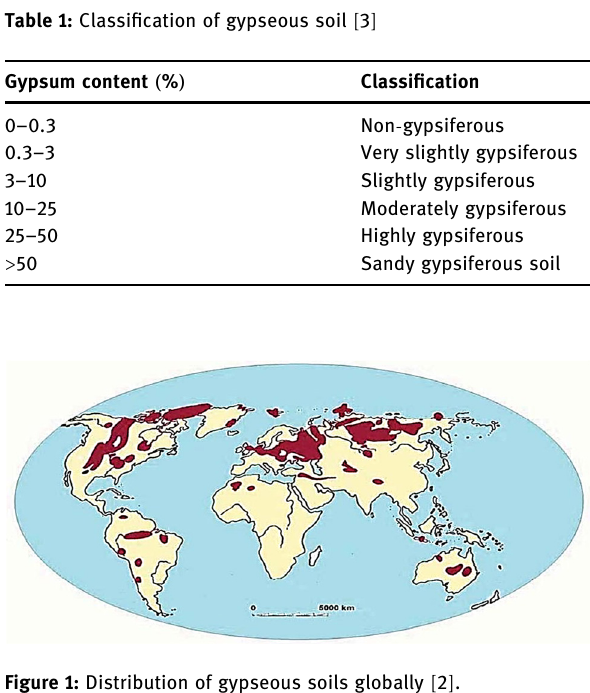
Figure 1: Distribution of gypseous soils globally [ 2 ] .